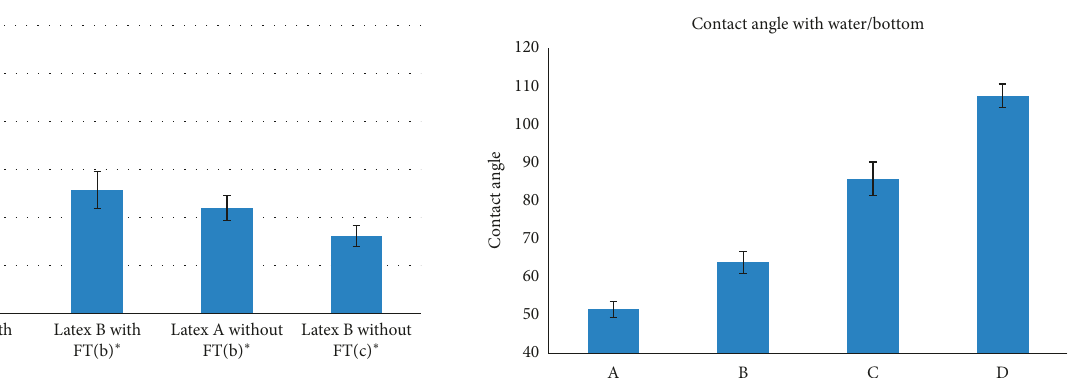
Figure 1: Surface energy of the top of the paperboard (white side), Figure 2: Effect of starch application and flame treatment on contact with and without flame treatment (FT), for both polar and non- angle of water on the bottom surface of the paperboard (brown side): polar latexes (A and B), respectively. Letters indicates similarities A: with starch/with flame treatment; B: with starch/without flame between samples, according to t -test at 95% confidence. ∗ treatment; C: without starch/with flame treatment; D: without starch/without flame (b) top of the paperboard coated by a nonpolar latex; and (c) bottom of the paperboard (brown side) both with and